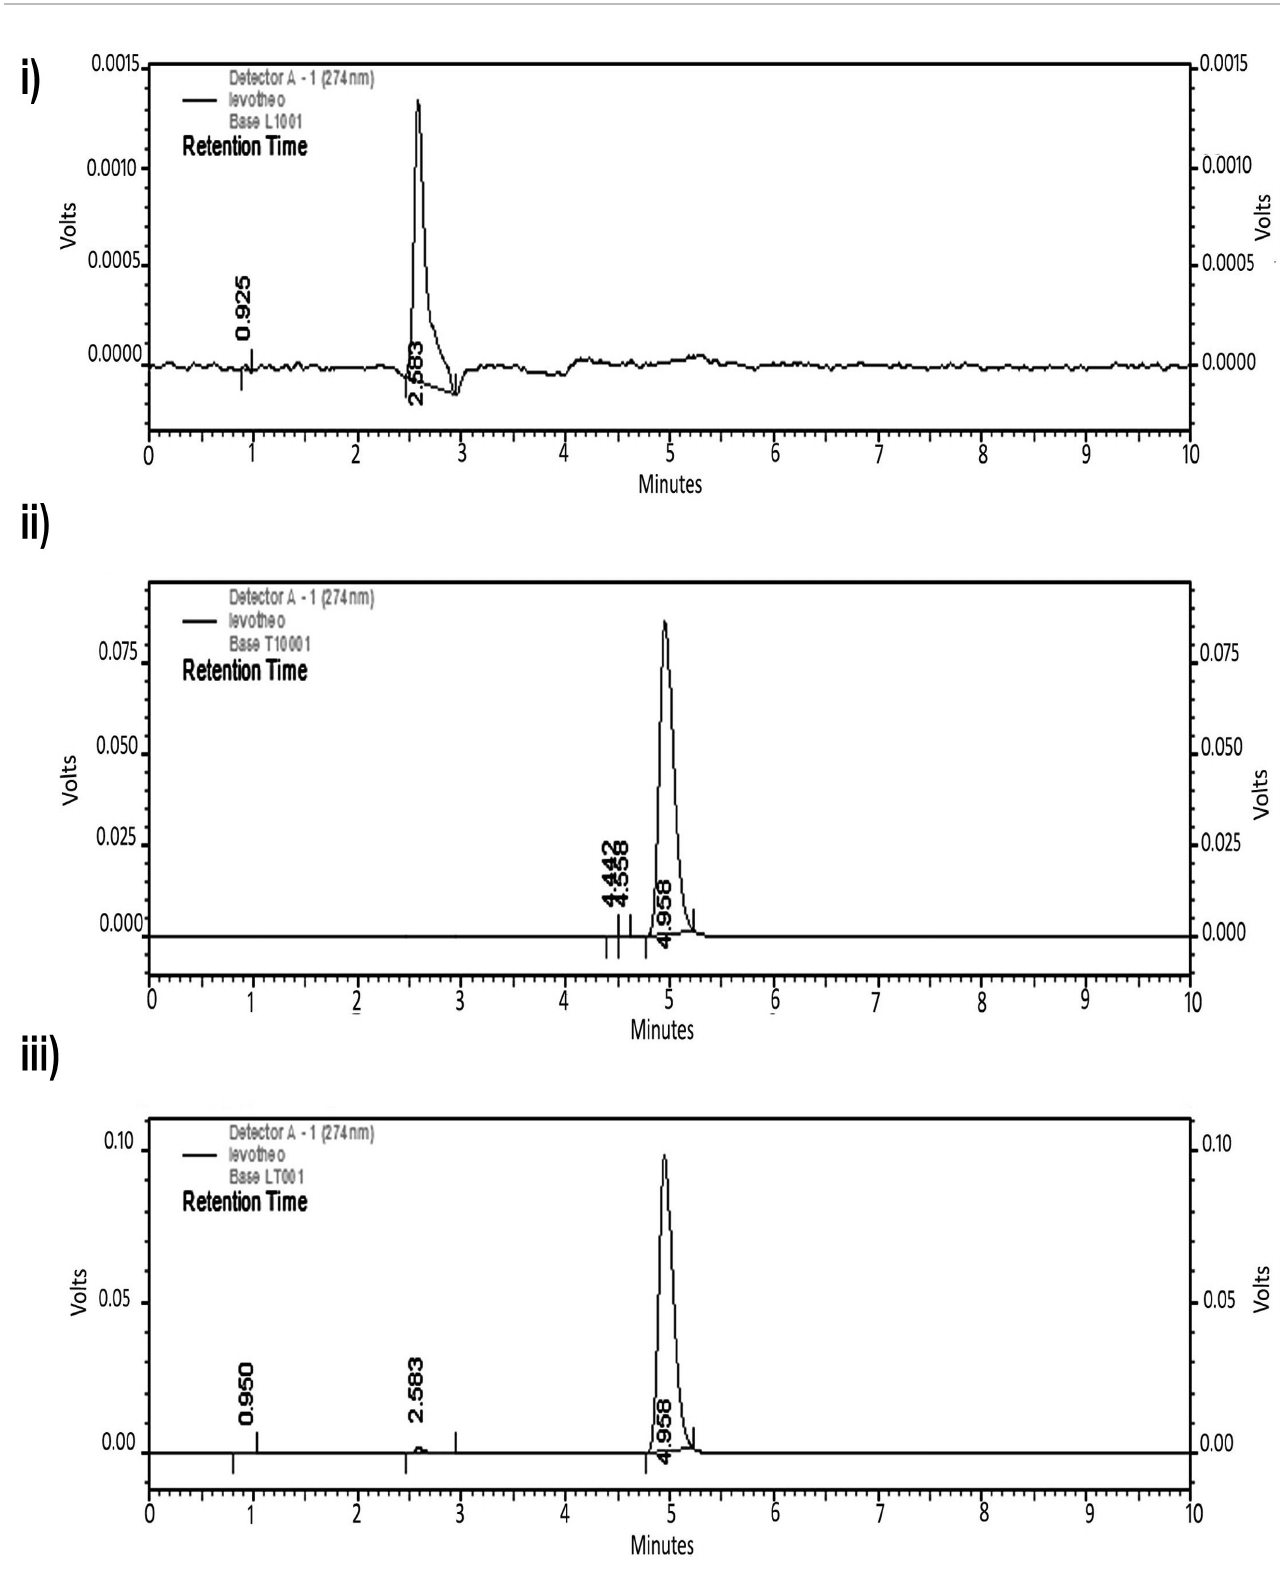
FIGURE 3C - Representative chromatograms of alkali degraded drugs. Each chromatogram represents (i) levosalbutamol sulfate (1 μg. mL -1 ), (ii) theophylline (10 μg. mL -1 ), (iii) dosage form having levosalbutamol sulfate (1 μg. mL -1 ) and theophylline (10 μg. mL -1